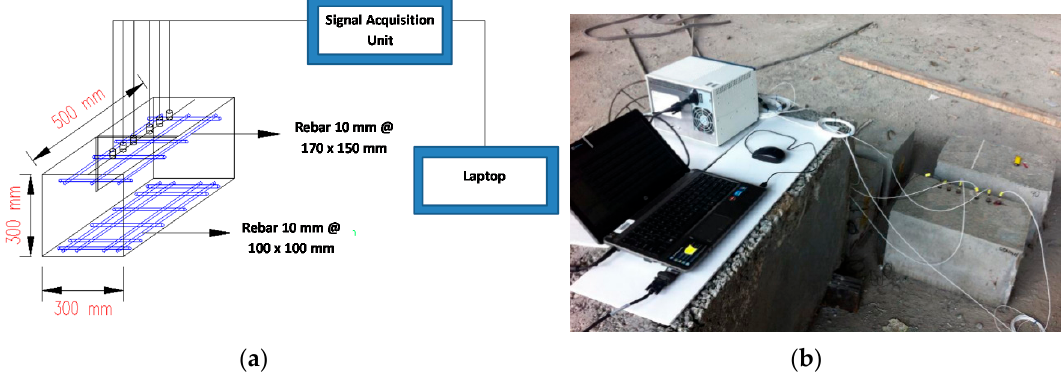
Figure 9. ( a ) Schematic representation of measurement setup; ( b ) photograph of laboratory measurement setup.